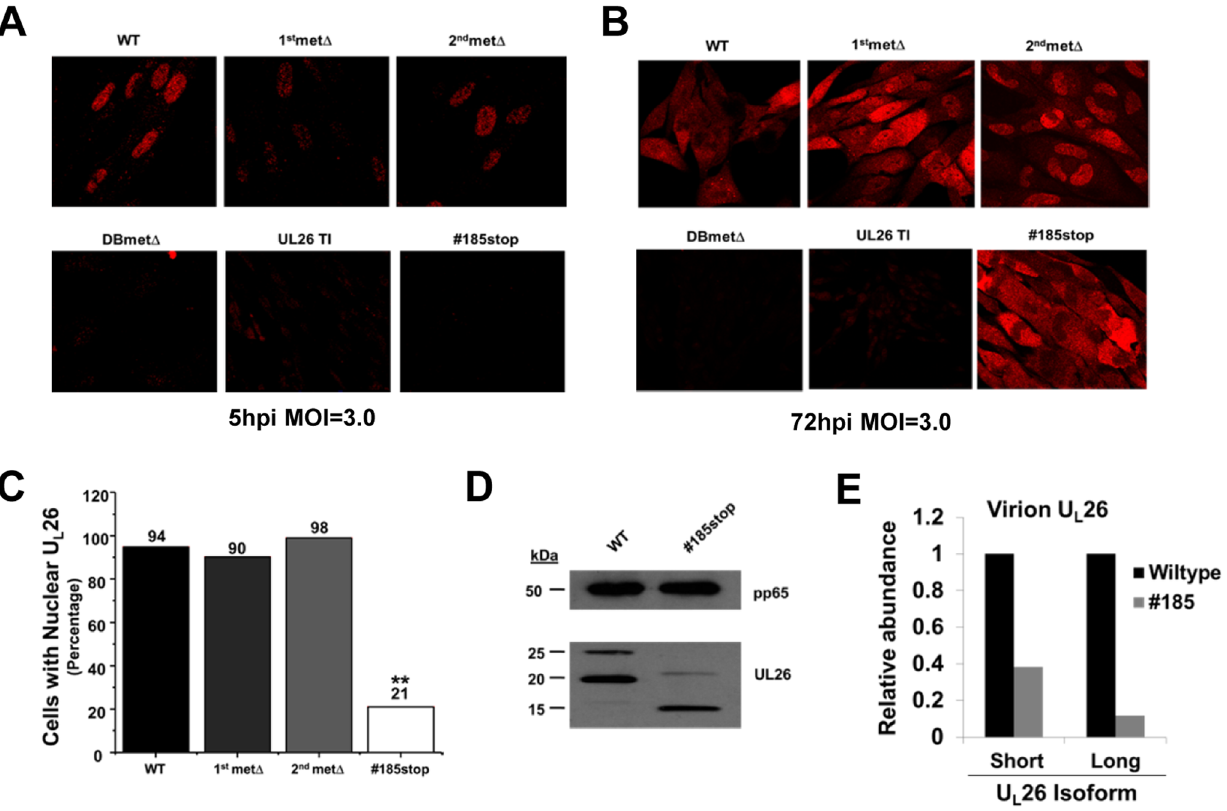
Figure 5. Analysis of HCMV plaque formation. ( A ) Replicate cultures of MRC5 fibroblasts were infected with 25 PFU of the indicated recombinant virus. Representative plaques at day 15 post infection for each virus are shown. ( B ) Areas of representative plaques for each virus were quantified by Image J and normalized to the WT plaque size. Values are means + SE (n=10). **=p , 0.01; ***=p , 0.001.